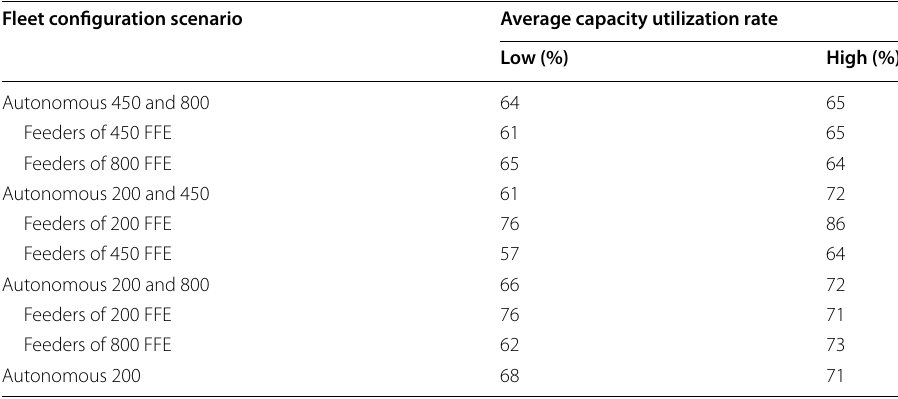
Table 9 Results of LSNDP for capacity utilization under the fixed schedule Fleet configuration